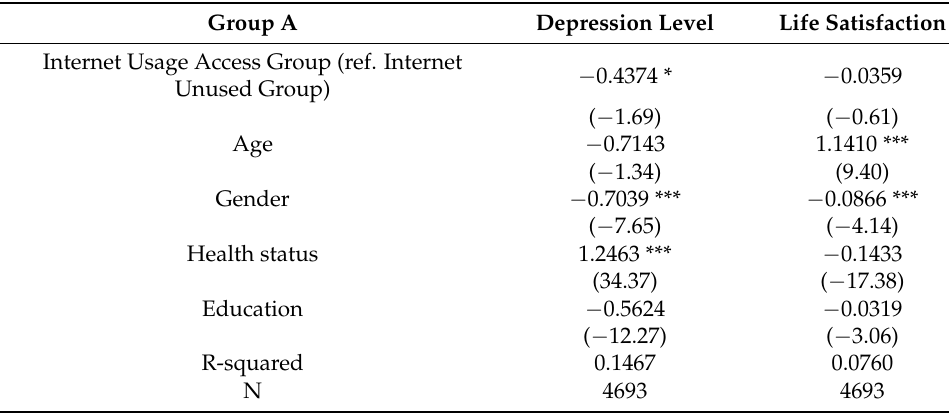
Table 4. Results of the DiD estimation (Group